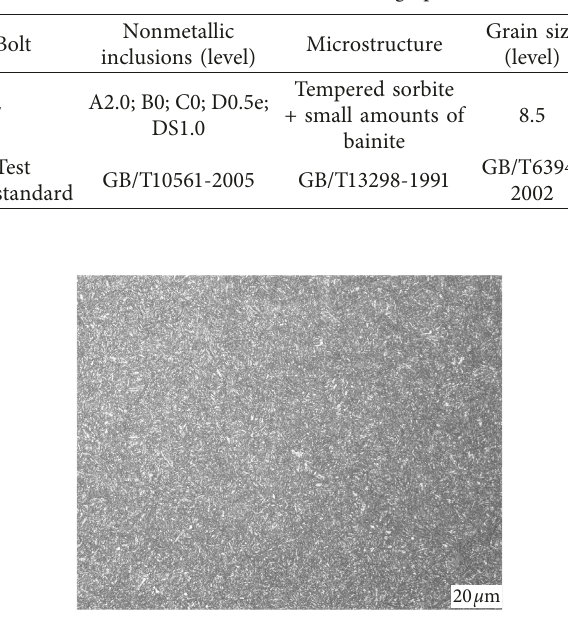
Table 2: The results of the metallographic test.